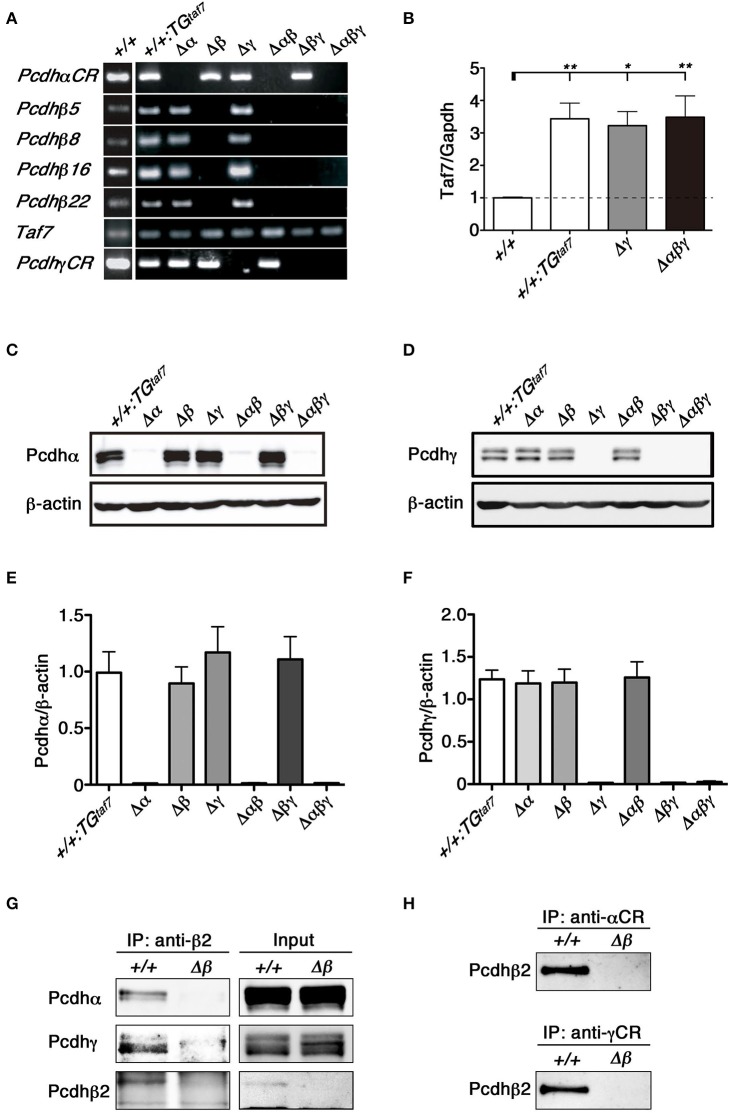
RT-PCR, immunoblot analysis and the co-association of Pcdhα, Pcdhβ, and Pcdhγ in vivo. (A) RT-PCR analysis of the whole brain of various mutant mice at E18.5. (B) Quantification of TAF7 transcripts of representative mutant animals at E18.5 by quantitative RT-PCR analysis. RT-PCR reactions in absence of reverse transcriptase showed the samples had no genomic DNA contaminants (data not shown). N = 4–5 animals per genotype. Error bars represent SEM. **P < 0.01 and *P < 0.05 by one-way ANOVA and post-hoc Tukey tests. (C,E) E18.5 brain lysates were immunoblotted with (C) anti-Pcdhα and (E) anti-Pcdhγ antibodies. (D,F) Quantification of (D) Pcdhα and (F) Pcdhγ proteins. N = 4 animals per genotype. Error bars represent SEM. There was no signifcance among these genotypes by one-way ANOVA and post-hoc Tukey tests. (G,H) The lysates of crude membrane fractions from the E18.5-P0 mouse brain were co-immunoprecipitated with (G) anti-Pcdhβ2, (H) anti-Pcdhα, or anti-Pcdhγ antibodies. The precipitates were immunoblotted with anti-Pcdhβ2, anti-Pcdhα, and anti-Pcdhγ.